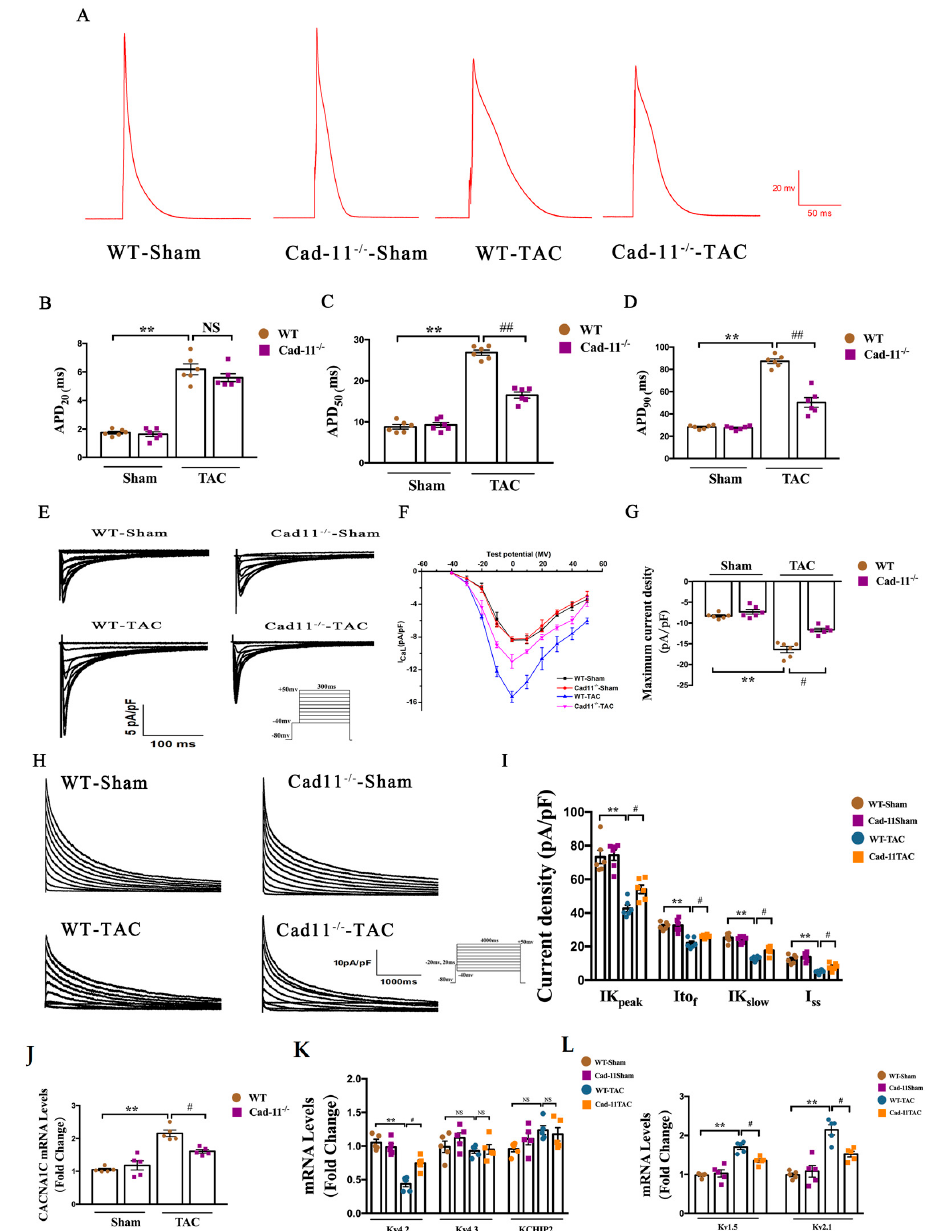
Figure 3. Cad-11 deficiency alleviated pressure overload-induced LV electrical remodeling. ( A – D ) Representative action potential curves for indicated mouse heart ( A ). ( B – D ) Statistical analysis of 20%, 50%, and 90% action potential durations (APDs) of LV myocytes isolated from Cad-11 − / − and WT mice that underwent sham or TAC surgery ( n = 6 mice each group). ( E ) Representative chart of L-type calcium current tracings in indicated mice. ( F ) Representative I-V curve of Ica,L. Current density-voltage (I–V) relationship of L-type calcium current were measured using patch clamp. ( G ) Maximum L-type calcium current density in the LV myocytes of WT or Cad-11 KO mice 4 weeks after sham or TAC operation ( n = 6 mice in each group). ( H ) Representative chart of voltage- dependent outward potassium current tracings. ( I ) Summary graph of the current density of outward potassium currents of WT and Cad-11 KO mice 4 weeks after sham or TAC operation ( n = 6 mice in each group). ( J – L ) The mRNA levels of the calcium channel subunit Cav1.2, potassium channel subunits Kv4.2, Kv4.3 (for I tof ), and Kv1.5, Kv2.1 (for I Kslow ) determined by qRT-PCR. N = 4 mice in each group. Data were presented as mean ± SEM, ** p < 0.01 vs. WT-Sham group. # p < 0.05, ## p < 0.01 vs. WT-TAC